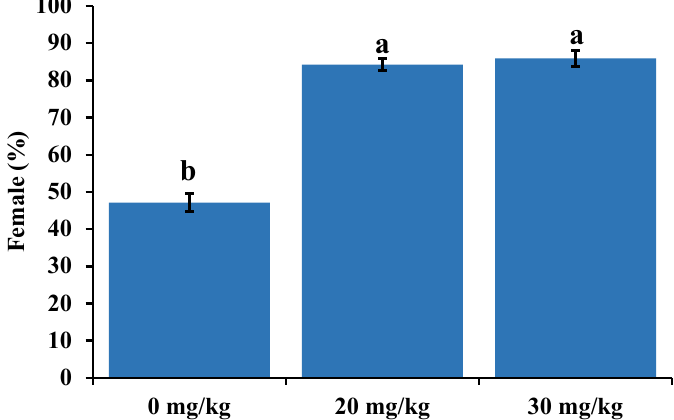
Figure 1. Mean ( ± SE) percentage of females in groups of brown trout Salmo trutta fed three different concentrations of estradiol/kg of feed for 60 days, starting at initial feeding. Bars with different letters above differ significantly ( p < 0.001).